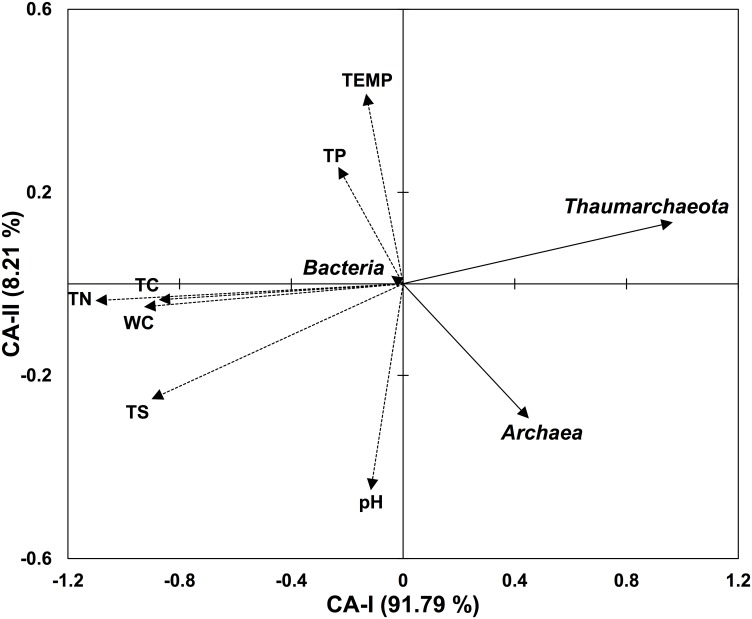
RDA biplot representing the relative abundance of prokaryotic taxa and environmental variables.Solid-line arrows and dashed-line arrows represent the biplot scores of the relative abundances of prokaryotic taxa and of the environmental variables, respectively. Values in parentheses indicate the percentages of the total variation that are explained by each canonical axis.